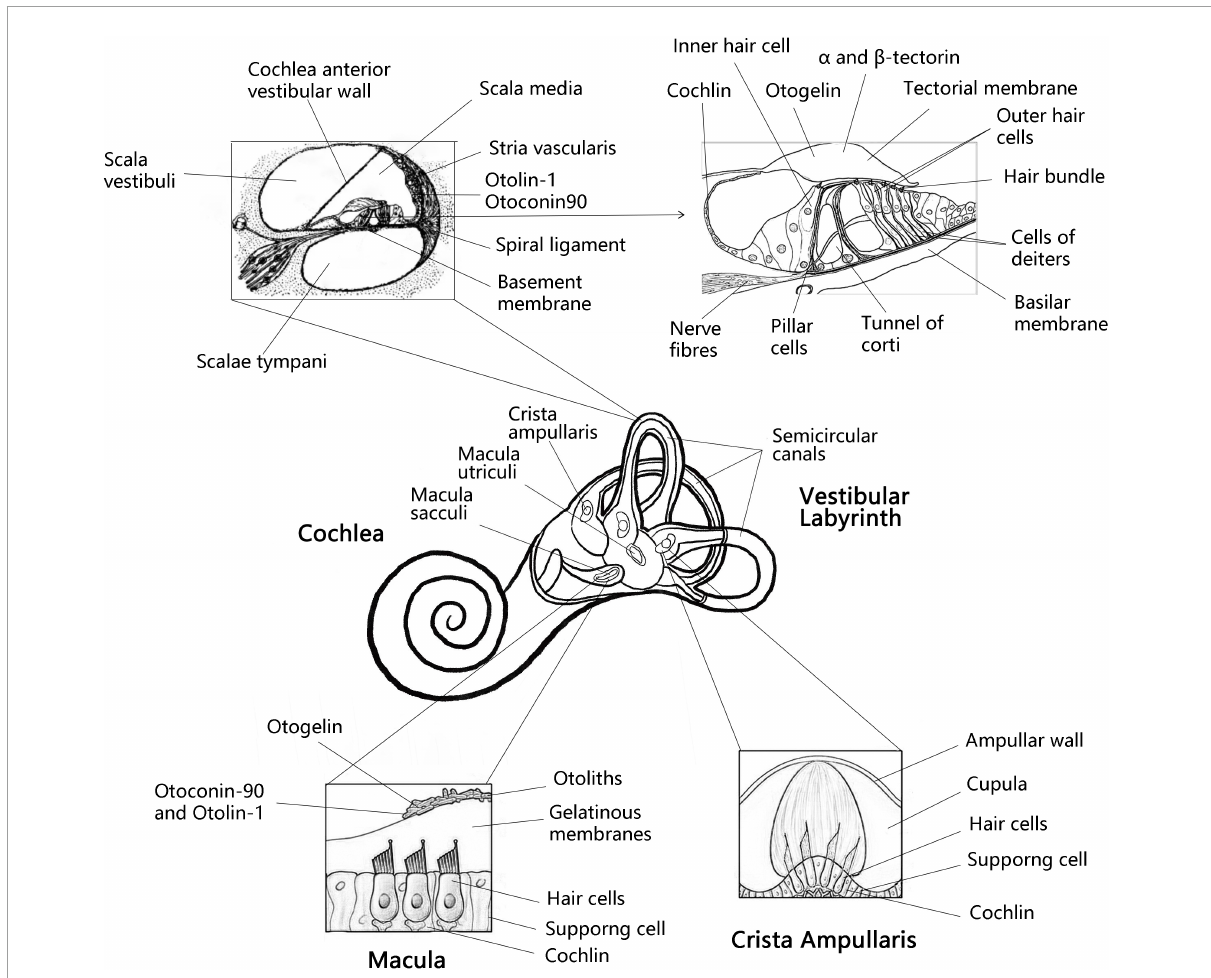
FIGURE1 Anatomy the vestibular labyrinth and organ of Corti with labeled structures and locations of inner otolith-related proteins. Anatomy of the vestibular labyrinth with labeled structures and locations of inner ear-exclusive proteins. Adapted from Encyclopaedia Britannica, Inc. 1997, by Jack